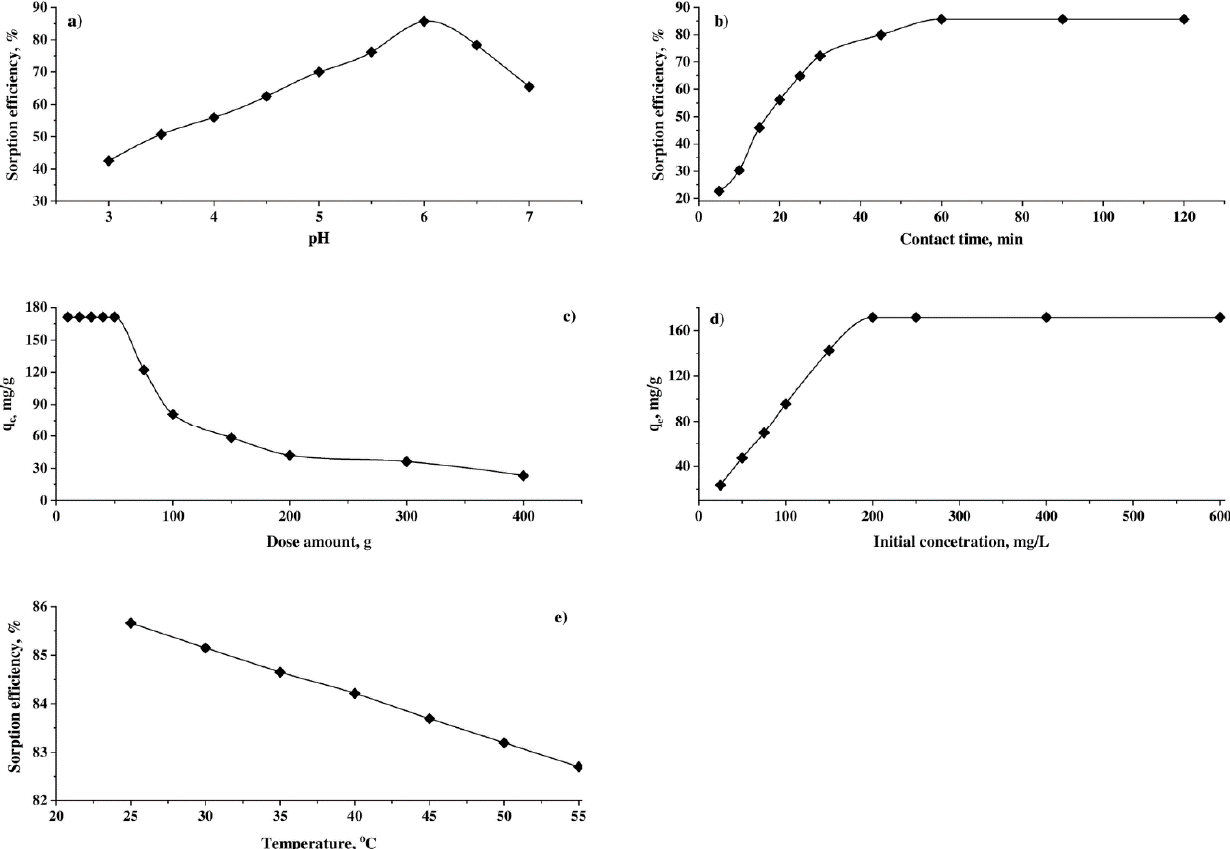
Figure 1. Influence of adsorption parameters on the uptake capacity of Y ions ( a ) pH (200 mg·L − 1 yttrium ions concentration, 50 mL volume, 60 min contact time, 0.05 g adsorbent dose, room temperature), ( b ) contact time (pH 6.0, 50 mL volume, 200 mg·L − 1 yttrium ions concentration, 0.05 g adsorbent dose, room temperature), ( c ) adsorbent dose (50 mL volume, 200 mg·L − 1 yttrium ions concentration, 60 min contact time, pH 6.0, room temperature), ( d ) initial yttrium ions concentration (50 mL volume, 60 min contact time, pH 6.0, room temperature, 0.05 g adsorbent dose), and ( e ) temperature (200 mg·L − 1 yttrium ions concentration, pH 6.0, 50 mL volume, 60 min contact time, 0.05 g adsorbent dose).